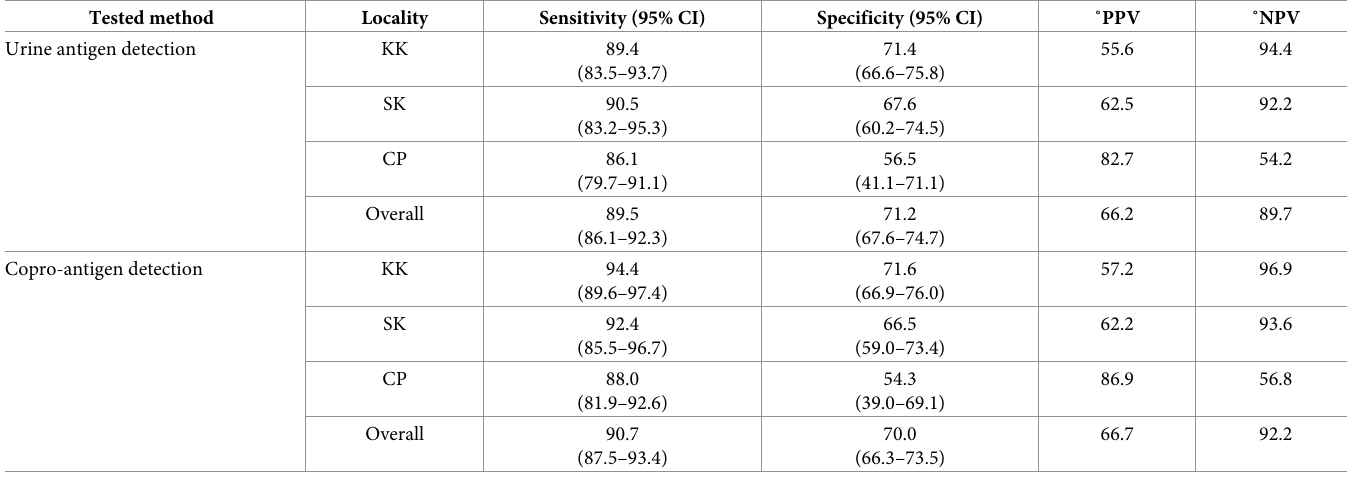
Table 3. Diagnostic performance of antigen detection by urine and copro-antigen detection in comparison with the gold standard FECT (n = 1043). Tested